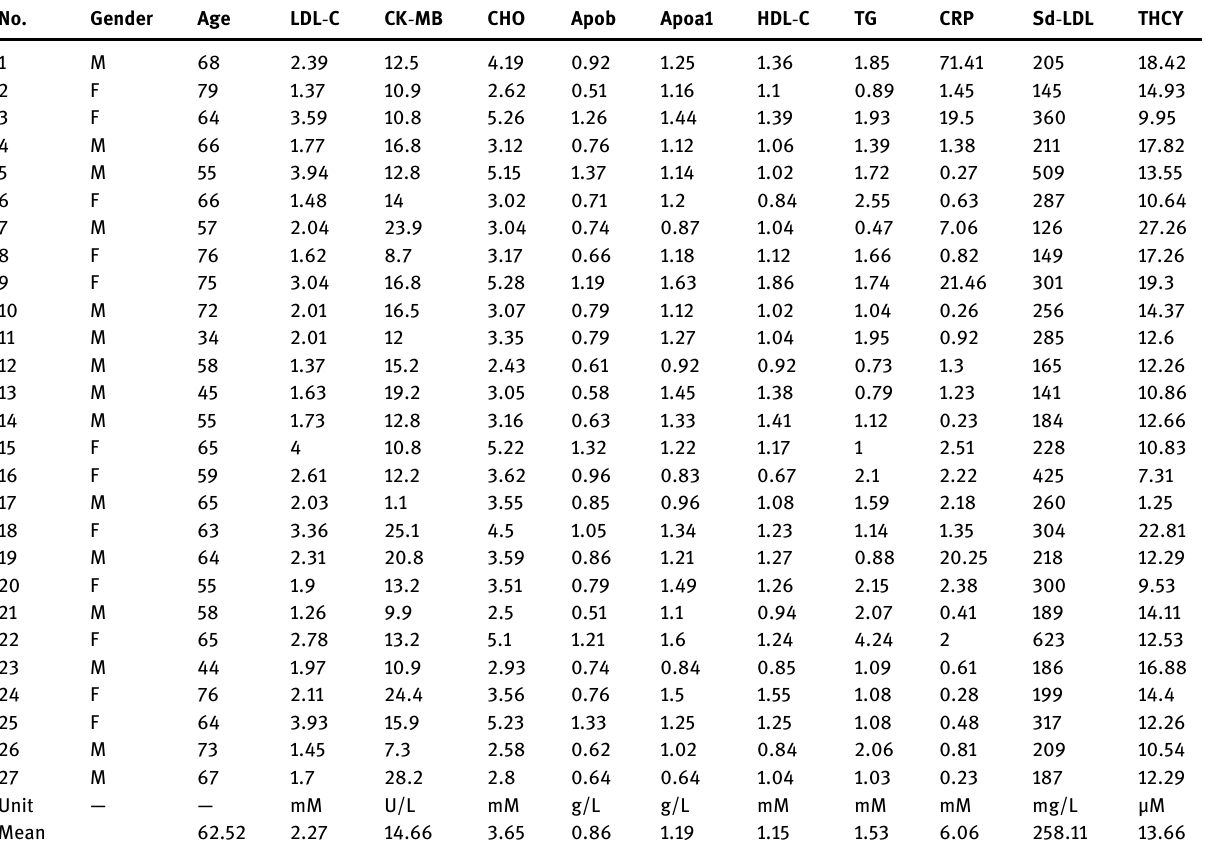
Table 1: Clinical information of patients with CHD